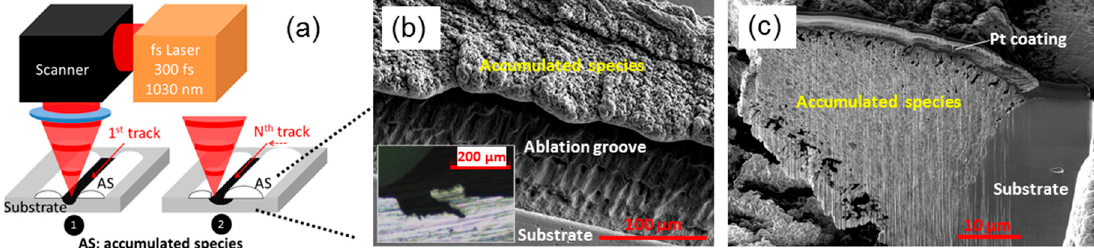
Figure 1. Ultrafast laser additive surface structuring (LASS) explained: ( a ) Laser scan path is indicated by the red arrows: the laser beam movement starts from the far side and advances linearly toward the near side to form a scan track. The scan tracks start from the right side and end on the left. The numbers 1 and 2 represent the beginning and the end of the process, respectively; ( b ) scanning electron microscope (SEM) micrograph showing the site of ablation, and additively grown part. A